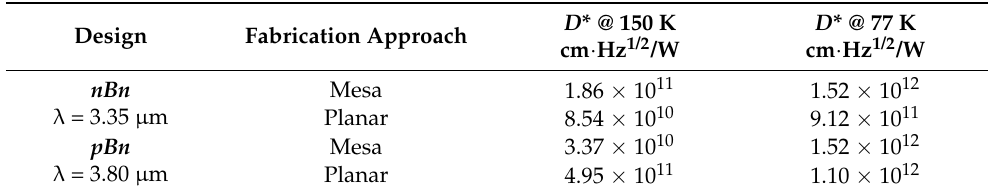
Figure 6. D * spectrum at ( a ) 77 K and ( b ) 150 K for planar and mesa-isolated MWIR SLS devices (diodes with 200 µ m diameter). The D * values were calculated using the equation in the inset, where k b is the Boltzmann constant, T is the operating temperature, J is the dark current, and R × A is the resistance area product. Table 3. Comparison of the D * values for planar and mesa-etched SLS devices at 77 and 150 K. (V b = − 40 mV for pBn and V b = − 80 mV for nBn